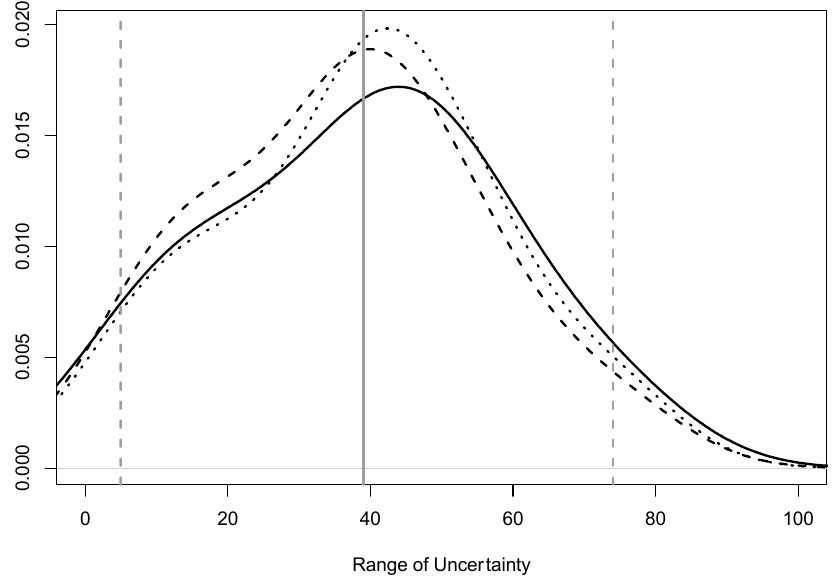
Figure 3. Density plot of the range of uncertainty about between-farm prevalence of bovine viral diarrhoea virus (BVDV) in beef breeder (dotted line), beef rearer (solid line) and dairy properties (dashed line) in a survey of veterinarians’ knowledge, attitudes and practices associated with BVDV management on properties in the temperate zone of south-east Australia in 2019. Vertical lines: grey solid = median combined between-property prevalence; grey dashed = 95% range of between-property prevalence. The extents of the plot <0 and >100 should not be interpreted; line extension is due to the smoothing process in constructing density plots.